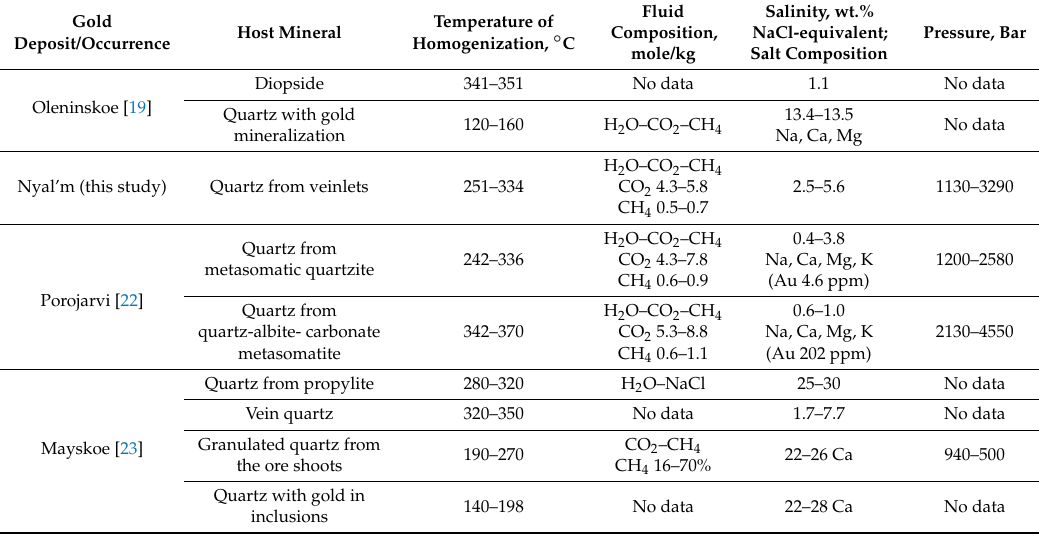
Table 5. Microthermometric data for individual fluid inclusions in rock-forming minerals from gold deposits in the Kola